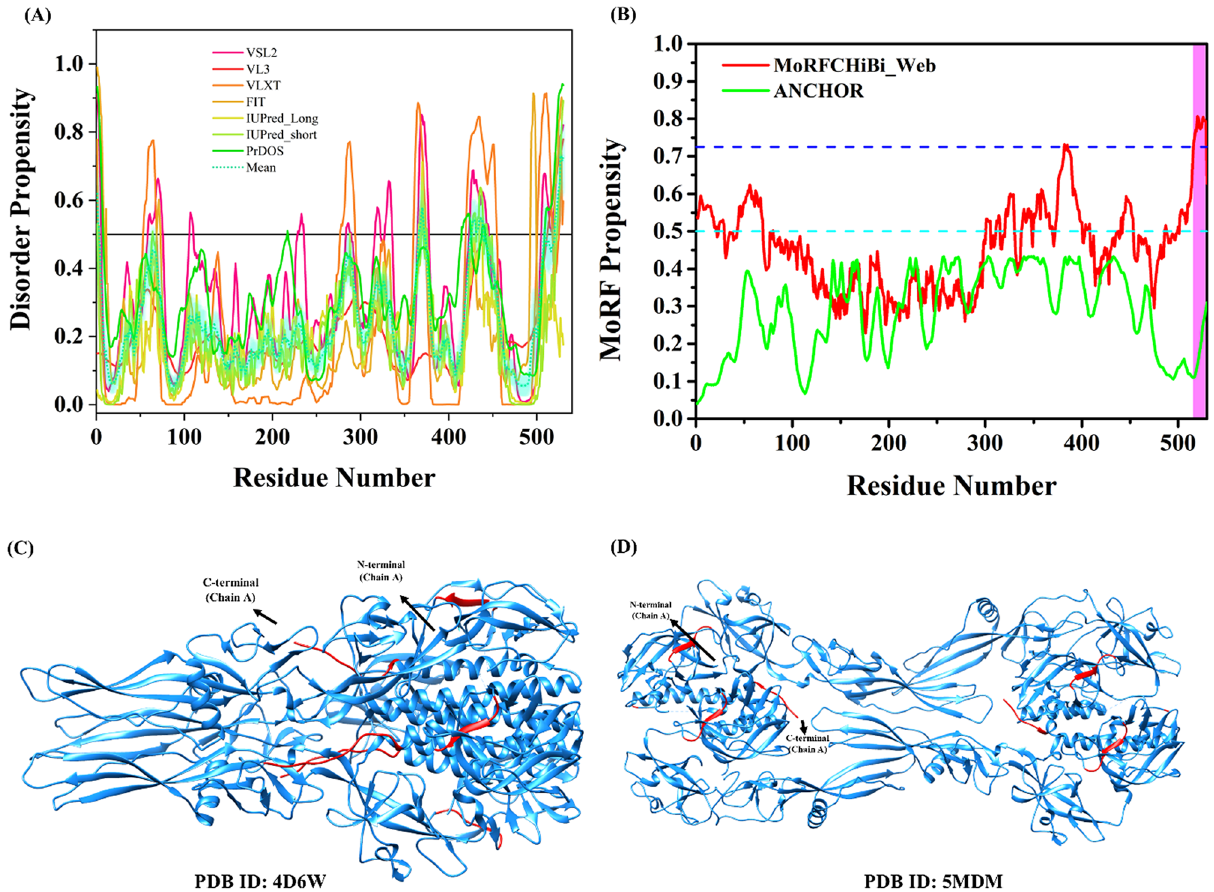
Figure 3. Intrinsic disorder predisposition of Glycoprotein (G). ( A ) The intrinsic disorder profile generated for Glycoprotein by a set of disorder predictors; PONDR VSL2, PONDR VL3, PONDR VLXT, PONDR FIT, IUPred2_long, and IUPred2_short are represented by black, red, blue, magenta, dark yellow-, and navy-colored straight lines respectively. A mean disorder profile calculated by averaging the outputs of seven predictors is represented by the green-colored short-dash line. Light green region around mean curve represents the error distribution for the mean. ( B ) Plot of MoRFs prediction by MCW and ANCHOR. Dashed cyan line (0.5) represents cut-off for ANCHOR and dashed blue line (0.725) represents cut-off for MCW server. The area with light magenta color represents MoRF region predicted by MCW server. ( C ) PDB ID: 4D6W. ( D ) PDB ID: 5MDM. Red colored regions are predicted to be disordered based on the calculated mean. The N- and C-terminals are shown with arrows for chain A in both